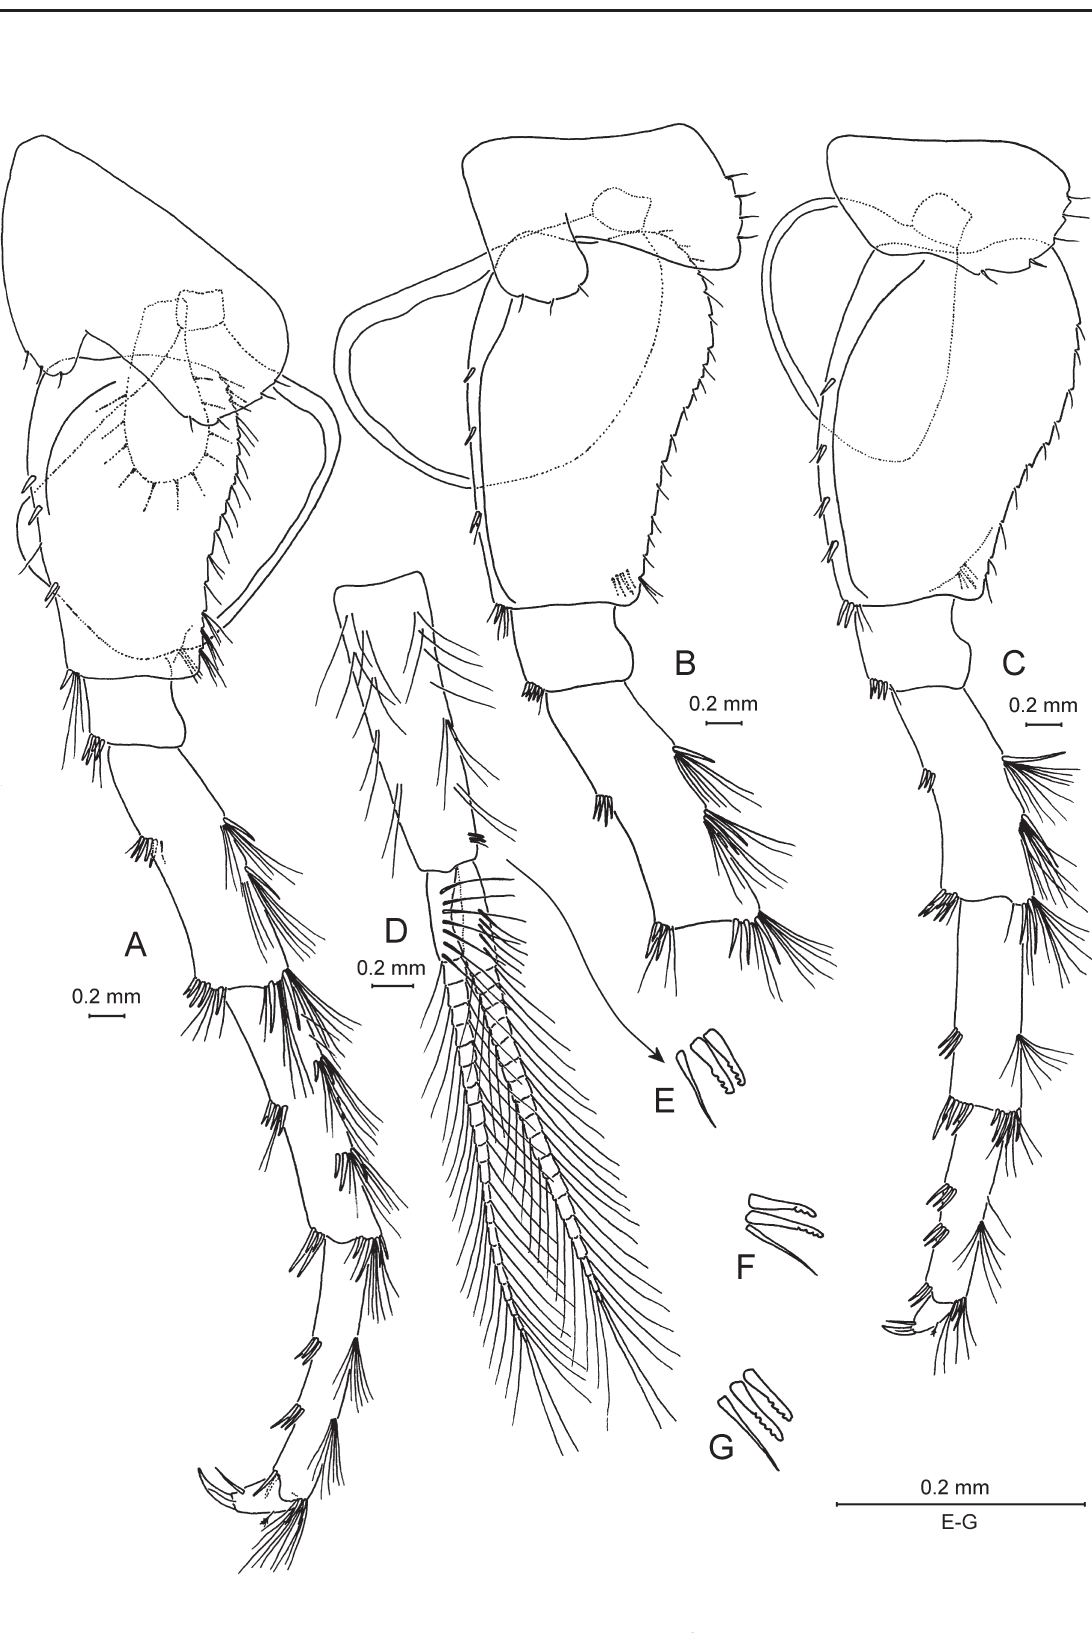
Fig. 15. Adaugammarus pilosus gen. et sp. nov. Holotype, ♀, 13.5 mm, X44046/Cr-1652-FEFU. A . Pereopod 5. B . Pereopod 6, part. C . Pereopod 7. D . Pleopod 1. E–G . Coupling setae of pleopods